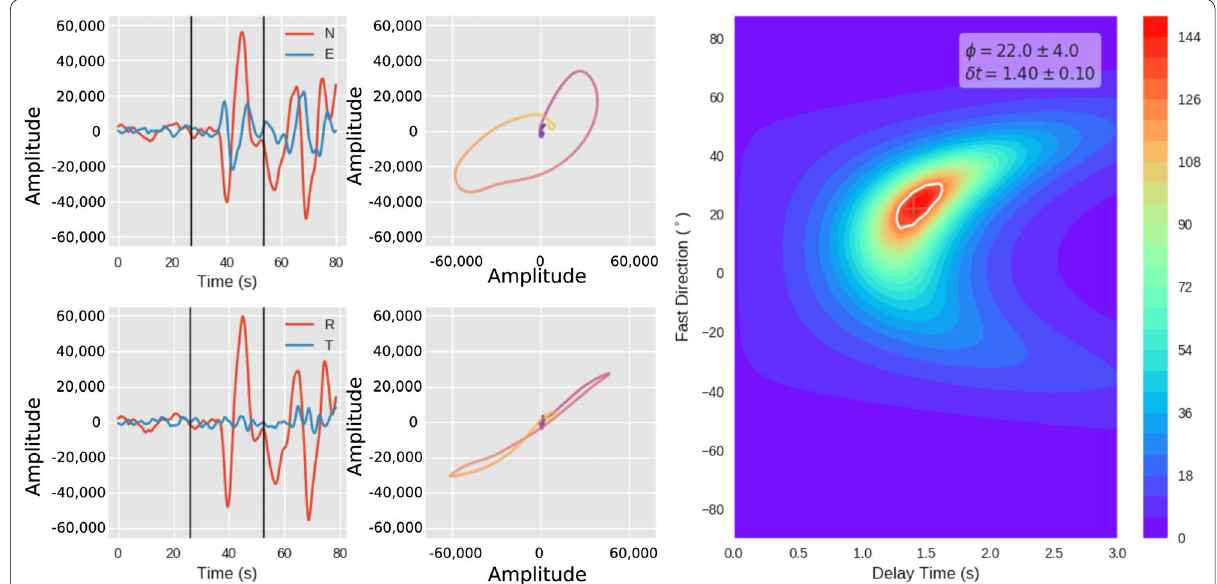
Fig. 9 (Top left) North and East components of the seismogram (same traces as in Figs. 7 and 8), with corresponding particle motion (center). (Bottom left) Radial and transverse components of the seismogram, with corresponding particle motion (center). (Right) Grid search results used to find the best-fitting parameters for the phase and delay